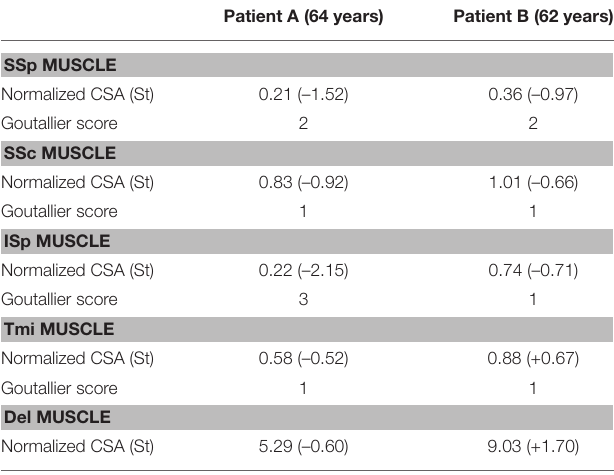
TABLE 4 | Radiological characteristics of subjects for